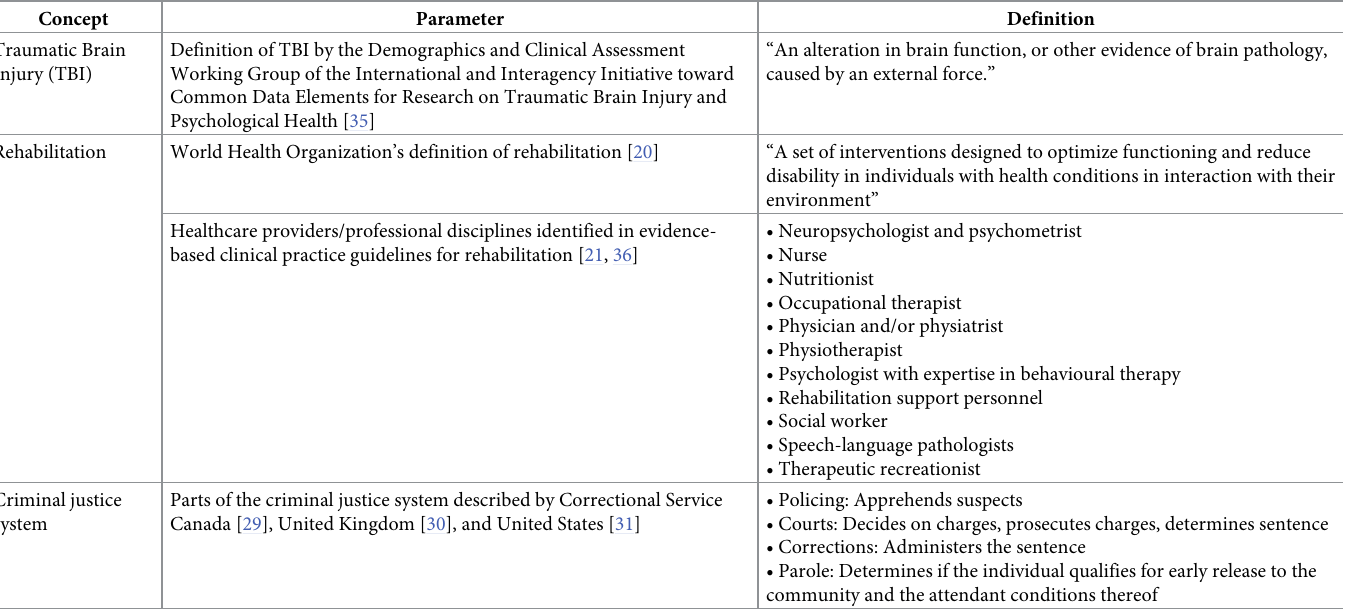
Table 1. Parameters and associated definitions for rehabilitation and the criminal justice